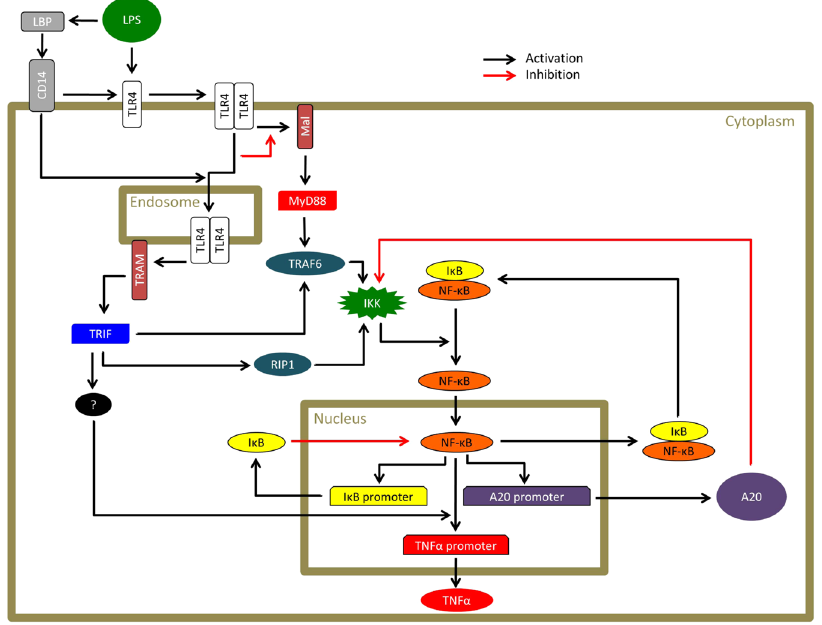
Figure 4. A representative schematic of the proposed TRIF contribution to NF- κ B-dependent TNF α promoter activation. LPS activates TLR4 at the cell surface resulting in MyD88 activation via Mal. LPS also promotes TLR4 endocytosis following association with CD14 in the presence of the LPS-binding protein (LBP). TLR4 in the endosome subsequently recruits TRIF via TRAM. TLR4 signalling is transduced sequentially through the MyD88-dependent pathway from the cell membrane and the TRIF-dependent pathway from the endosome. Signals through MyD88-dependent and TRIF-dependent pathways distinctly activate I κ B kinase (IKK) via the TNF receptor associated factor 6 (TRAF6) and the kinase receptor interacting protein 1 (RIP1). Activated IKK causes phosphorylation and degradation of I κ B followed by NF- κ B translocation to the nucleus. In the nucleus, NF- κ B activates several promoters. NF- κ B requires the cooperation of TRIF-dependent signalling to activate the TNF α promoter. NF- κ B also activates promoters of negative regulators including I κ B and A20. I κ B inactivates NF- κ B and leads it to shuttle out of the nucleus. A20 suppresses IKK through inhibition of the upstream